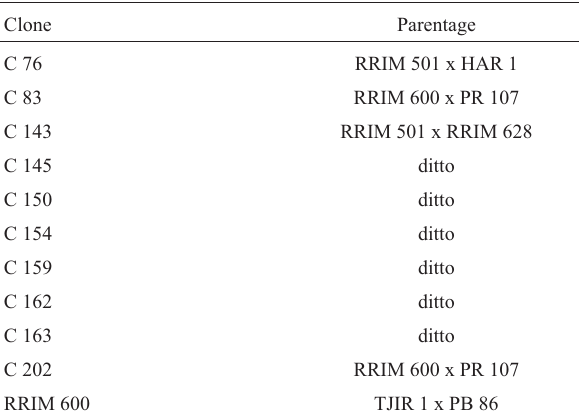
Table 1 - Parentage of the experimental clones.